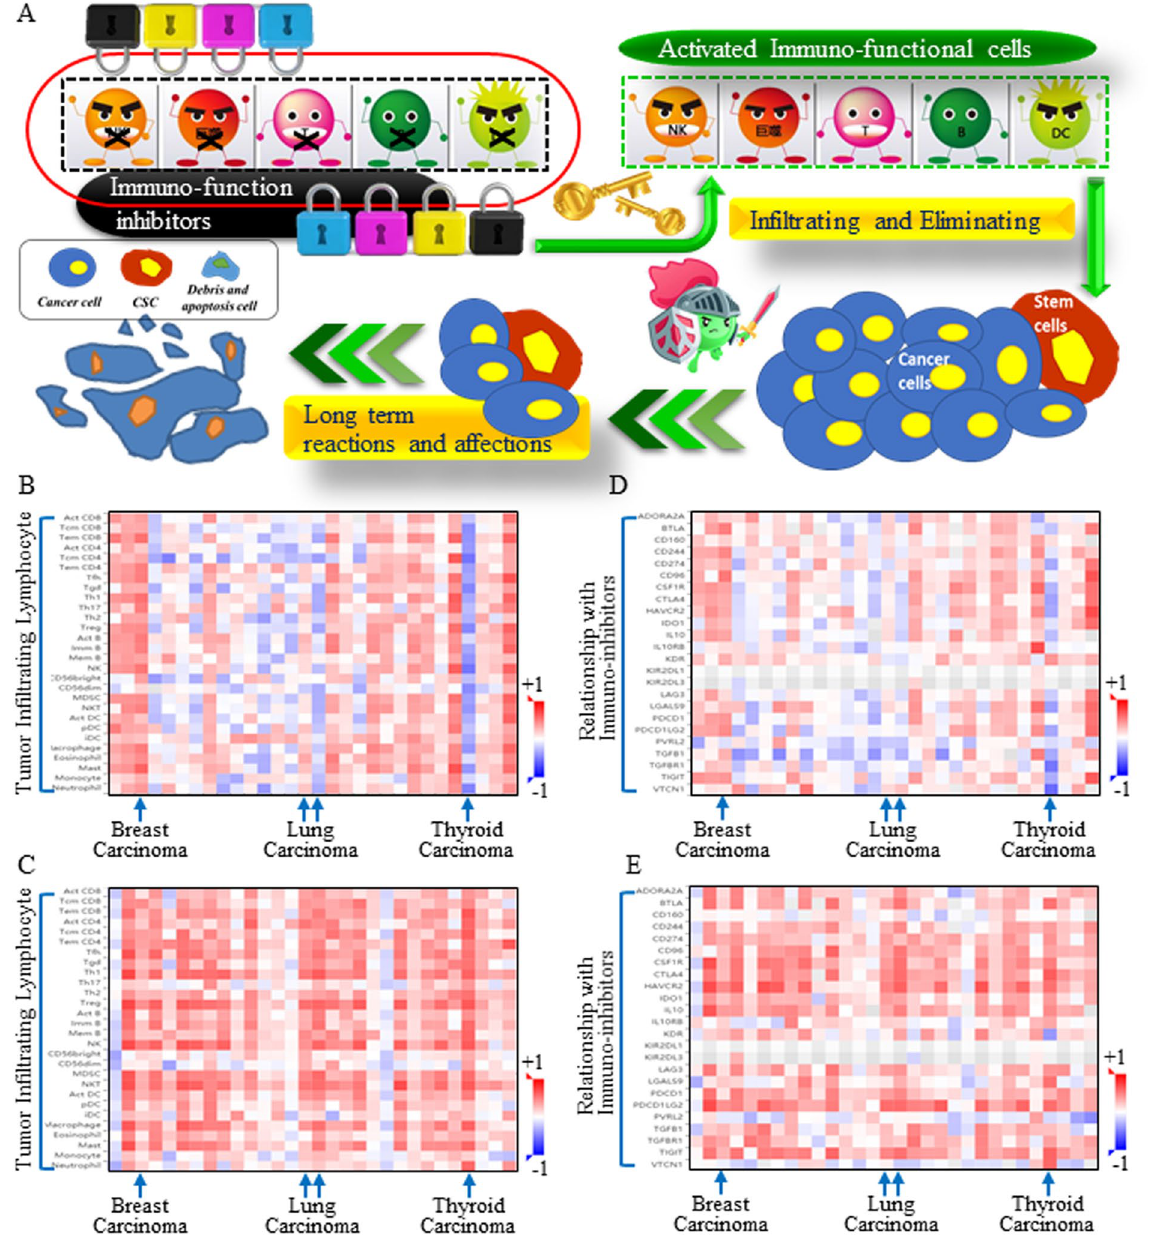
Figure 4. TNFSF4-based immunotherapy may intersect with cancer stem cell signature repression. ( A ) Schematic figure illustrating the immune response. the immune system becomes suppressed when a carcinoma becomes aggressive. Later, when immune function inhibitors are blocked, active immune cells begin to infiltrate and exert cytotoxic activities against all tumor cells. Spearman correlations between TNFSF4 and immunoinhibitory factors (Y axis) across human cancers (X axis). The items in the column are listed in sequence as follows: ADORA2A, BTLA, CD160, CD244, CD274, CD96, CSF1R, CTLA4, HAVCR2, IDO1, IL10, IL10RB, KDR, KIR2DL1, KIR2DL3, LAG3, LGALS9, PDCD1, PDCD1LG2, PVRL2, TGFB1, TGFBR1, TIGIT, and VTCN1. The infiltrating lymphocyte functions and connective functional factors were analyzed, and both ALDH1A1 overexpression ( B ) and TNFSF4 overexpression ( C ) were correlated with more lymphocyte infiltration. Spearman correlations between TNFSF4 and kinds of lymphocytes (Y axis) across human cancers (X axis). The items in the column are listed in sequence as follows: ADORA2A, BTLA, CD160, CD244, CD274, CD96, CSF1R, CTLA4, HAVCR2, IDO1, IL10, IL10RB, KDR, KIR2DL1, KIR2DL3, LAG3,